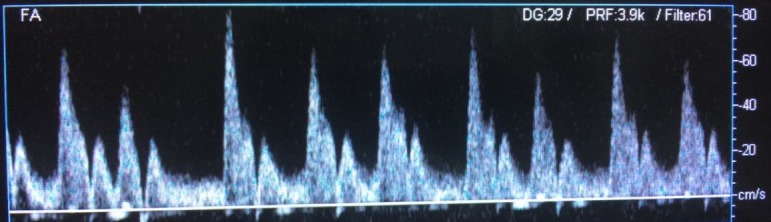
Atrial fibrillation.